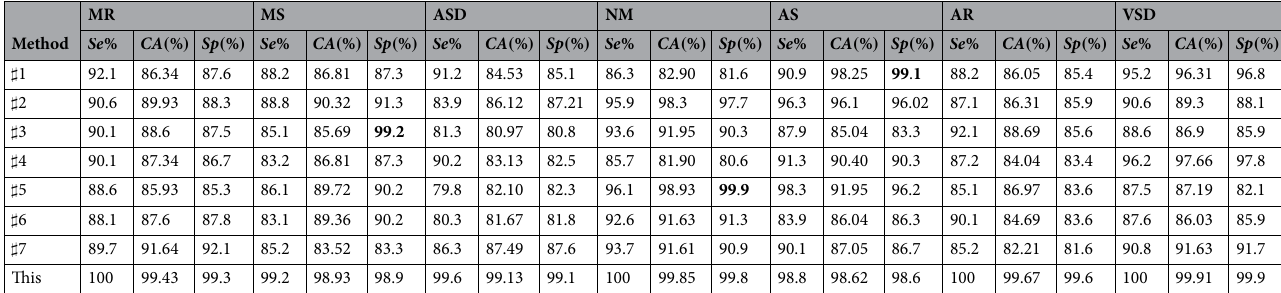
Table 7. Comparative analysis of eight different methods for the diagnosis of heart diseases summarized in Table 5.